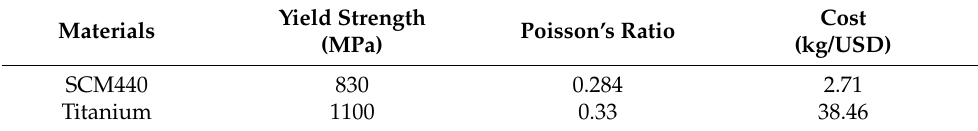
Table 4. Mechanical properties of the shaft materials.